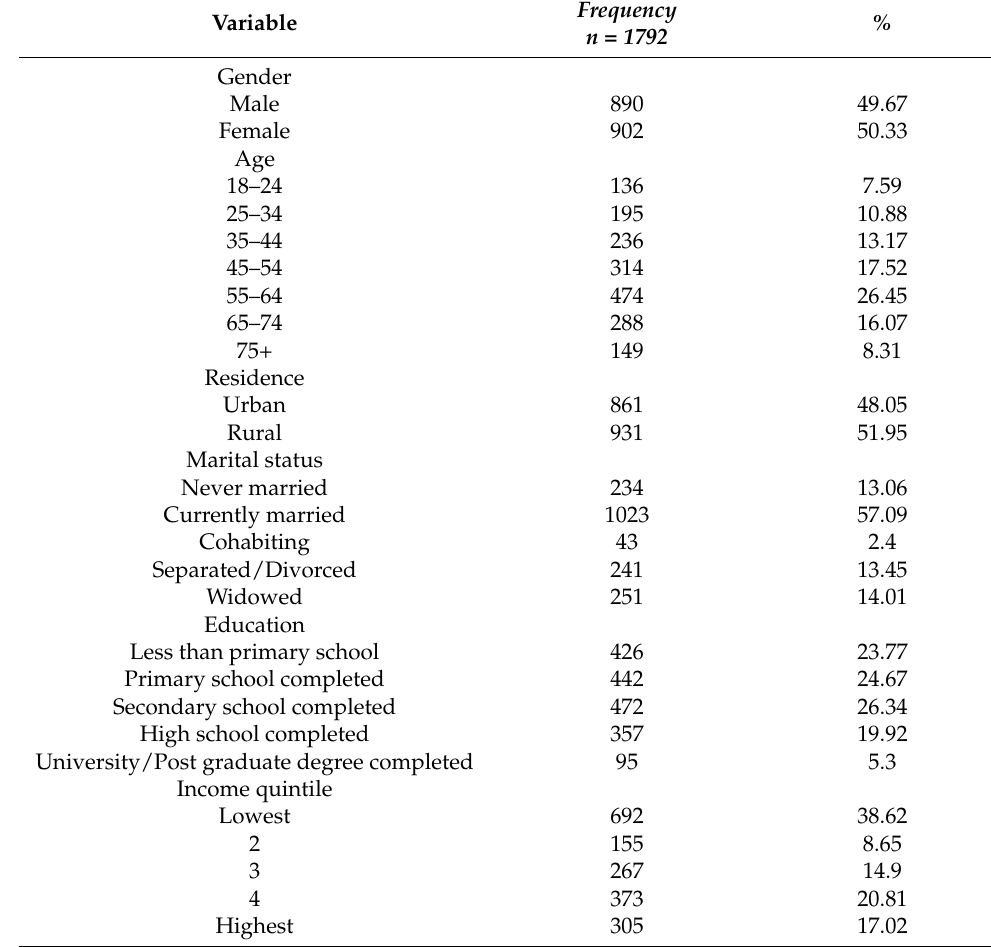
n = Sample size; % = Percent.